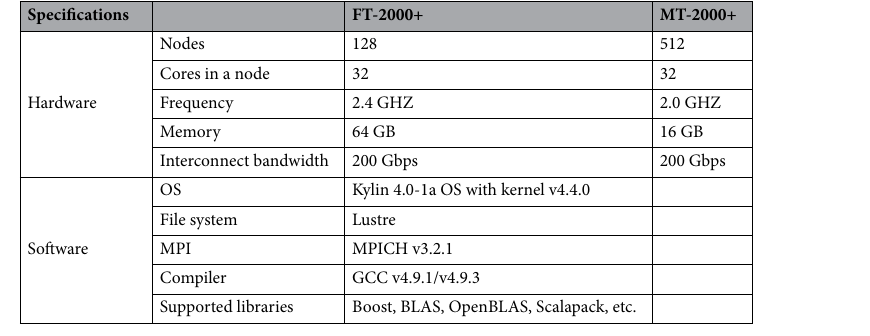
Table 1. Basic situation of Tianhe-3 prototype